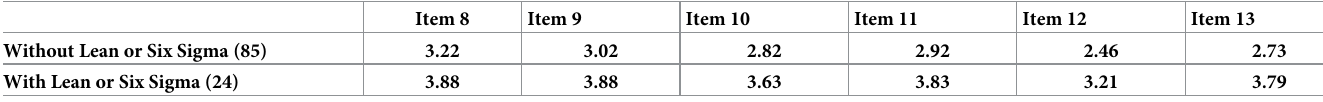
Table 10. Mean scores of items 8 to 13 for business performance.